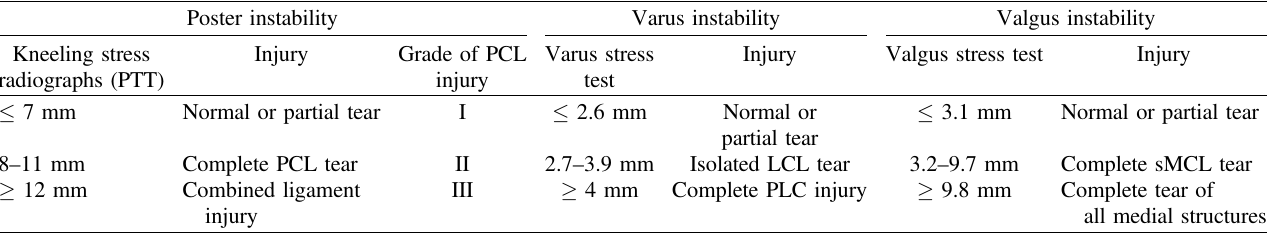
LCL, lateral collateral ligament; PCL, posterior collateral ligament; PLC, posterolateral corner; PTT, posterior tibial translation; sMCL, super fi cial medial collateral